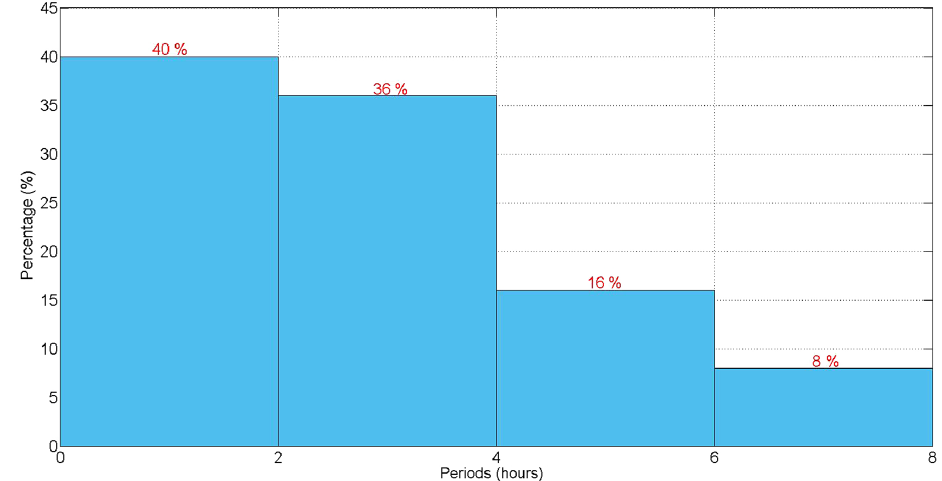
Figure 5. Histogram of the percentage of the main frequencies in B x geomagnetic field component in the magnetotail during